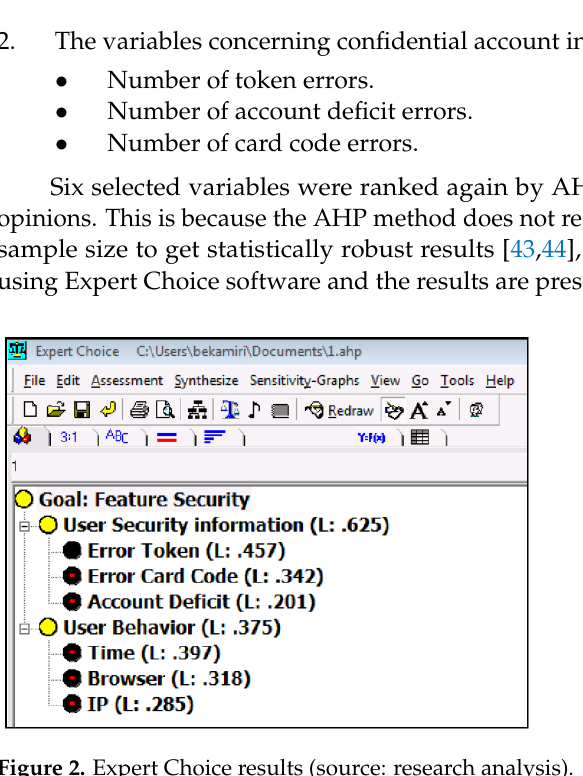
Table 2. Values and intervals of main variables in fuzzy system (source: research analysis).